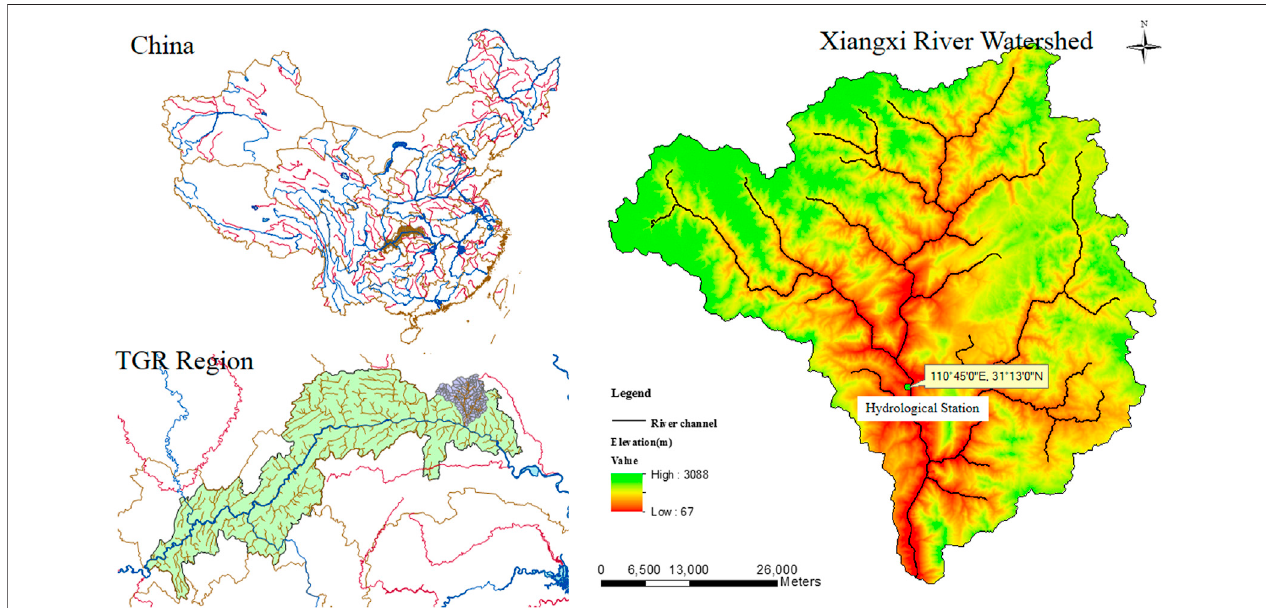
FIGURE 2 | The Studied are (Fan et al.,